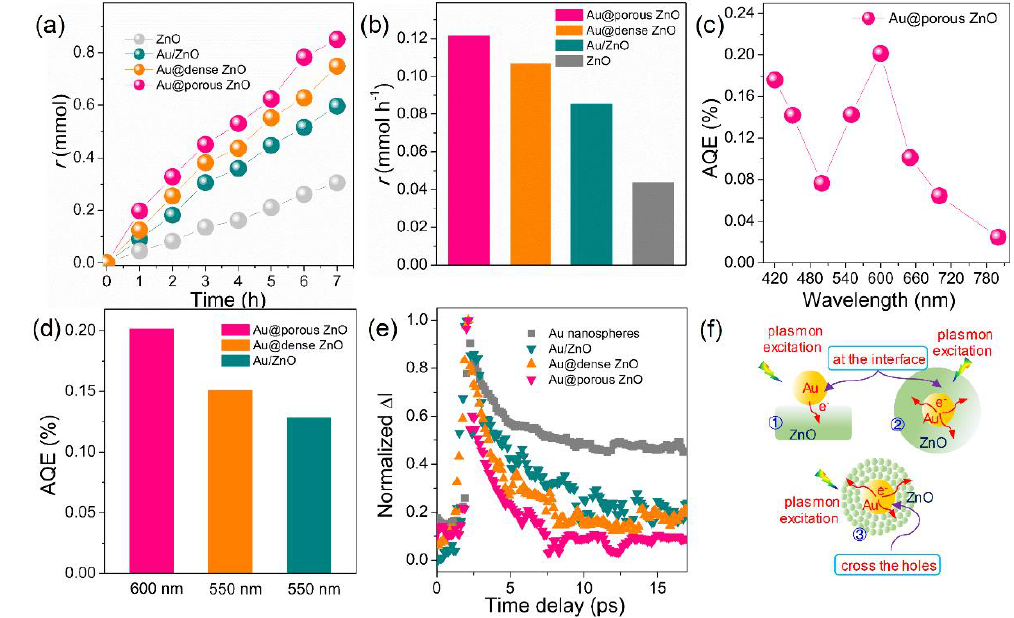
Figure 3. ( a , b ) Photocatalytic hydrogen generation rates of ZnO and the structure-adjustable Au-ZnO hybrids. ( c ) Apparent quantum efficiency (AQE) of the Au@porous ZnO hybrids. ( d ) AQEs of the structure-adjustable Au-ZnO hybrids tested at their plasmon resonances. ( e ) Normalized time-resolved optical differential transmission for Au and the structure-adjustable Au-ZnO hybrids. ( f ) Schematic illustrating the possible hot electron injection processes in the structure-adjustable Au-ZnO hybrids.